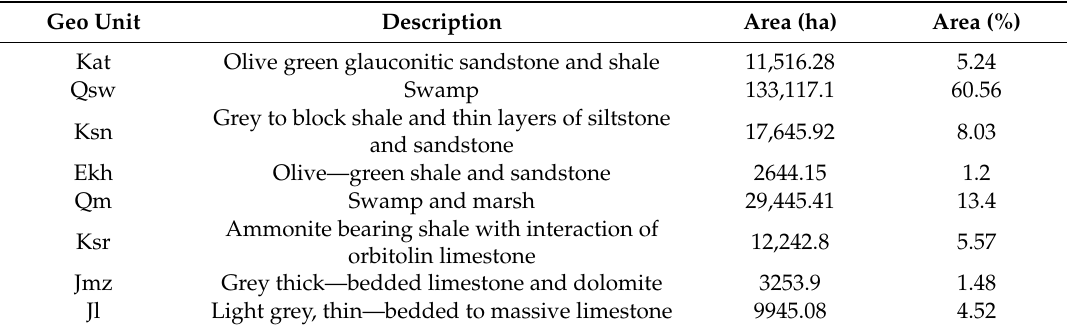
Table 2. Lithology of the study